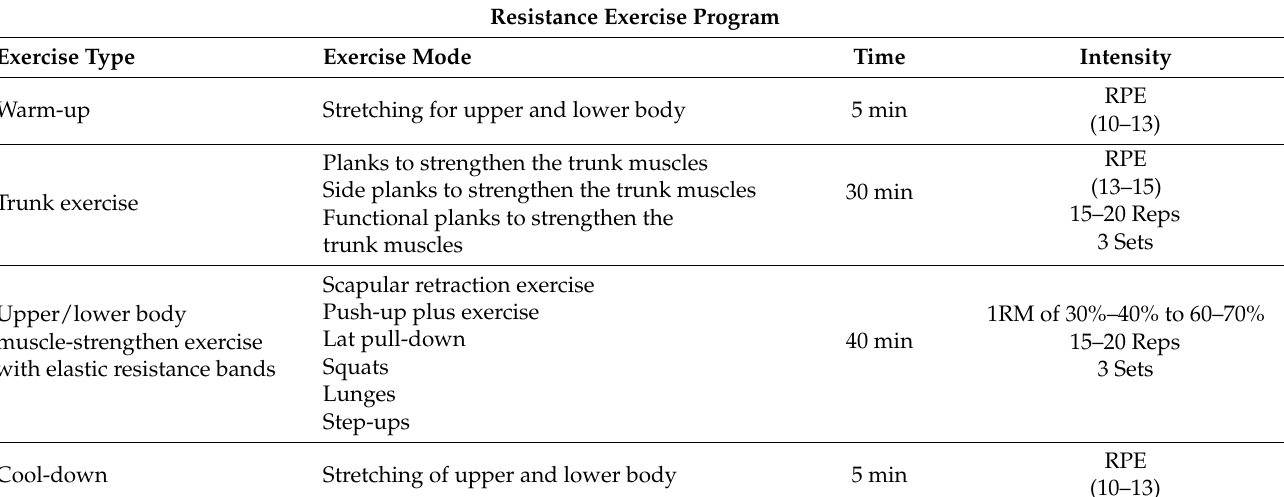
Table 2. The resistance exercise program.